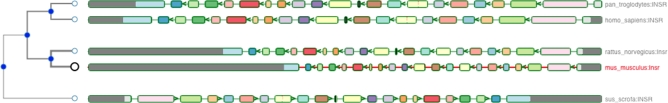
Homologous genes of insulin receptor (INSR) of Mus musculus from Pan troglodytes, Homo sapiens, Rattus norvegicus, and Sus scrofa.